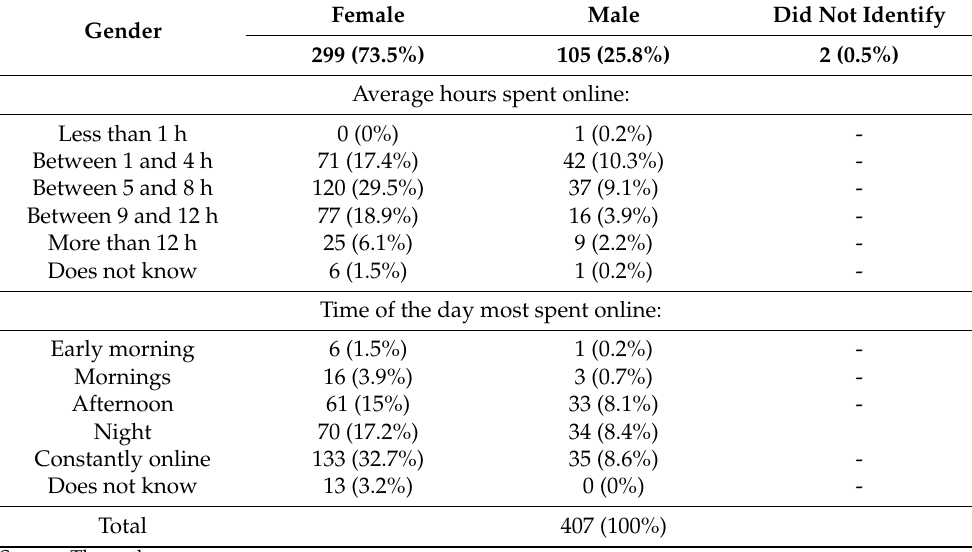
Table 3. Average hours per day spent on the Internet and the periods thereof, by